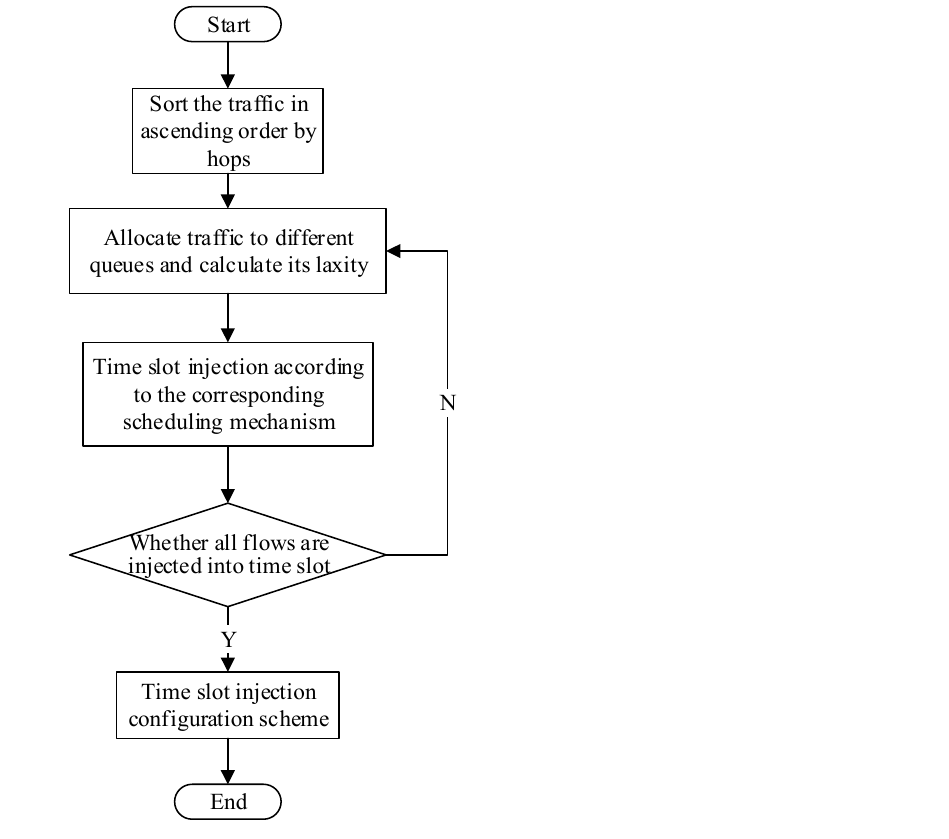
Figure 5. Workflow of traffic shaping stage.